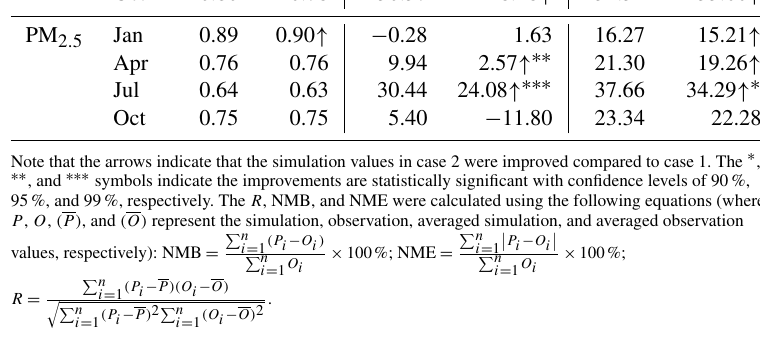
Note that the arrows indicate that the simulation values in case 2 were improved compared to case 1. The ∗ , ∗∗ , and ∗∗∗ symbols indicate the improvements are statistically significant with confidence levels of 90%, 95%, and 99%, respectively. The R , NMB, and NME were calculated using the following equations (where P , O , ( P) , and (O) represent the simulation, observation, averaged simulation, and averaged observation (cid:80) n i = 1 (Pi − Oi) (cid:80) n values, respectively): NMB = i = 1